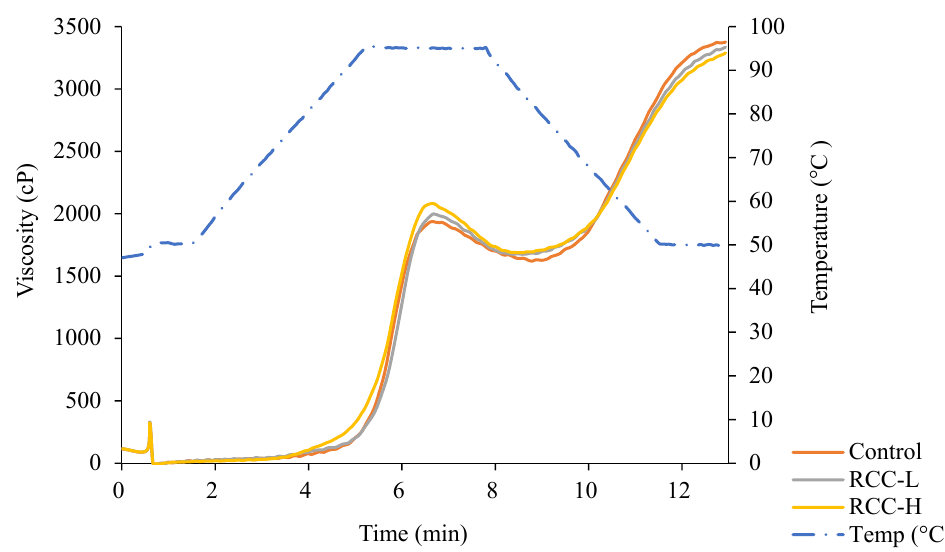
Figure 3. Changes in viscosity among different rice samples. Table 4. Viscosity behaviors of the control and rice-CGA complex samples.